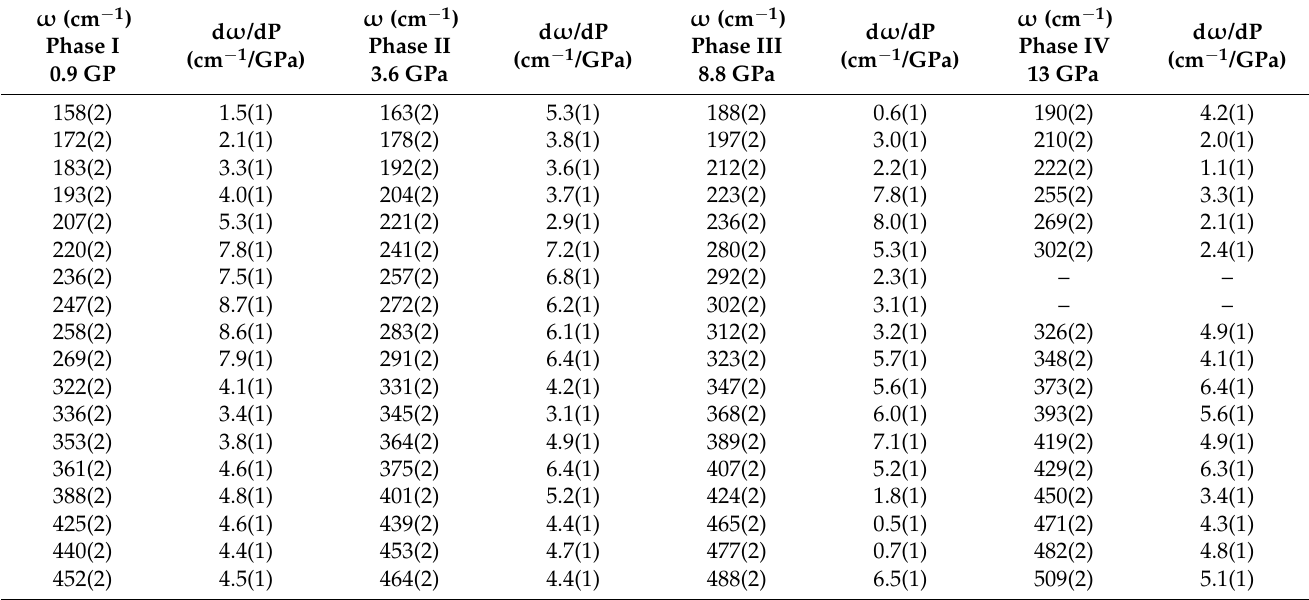
Table 2. Phonon frequencies ( ω ) of the modes observed under compression for phases I (at 0.9 GPa), II (at 3.6 GPa), III (at 8.8 GPa, and IV (at 13 GPa). The pressure coefficients (d ω /dP) obtained from linear fits are also